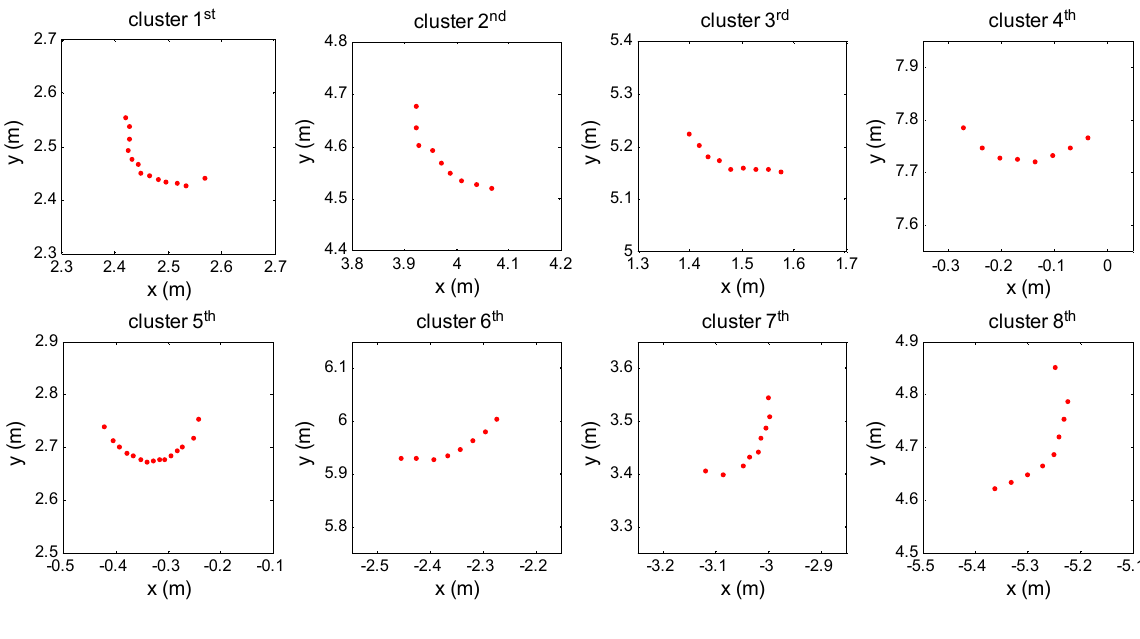
Figure 5. The point cloud in clusters after